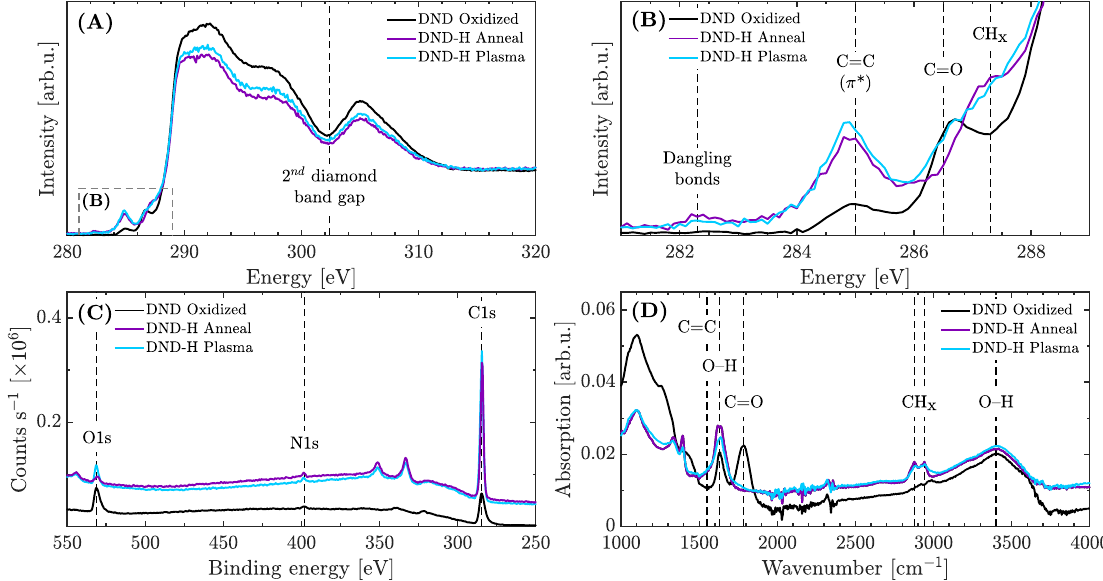
Figure 3. Spectroscopic characterization of hydrogenated DND materials and the oxidized starting material. ( A ) NEXAFS spectra of carbon K-edge; ( B ) carbon K-edge spectra displayed between 281 and 289 eV to highlight pre-edge features; ( C ) XPS survey; and ( D ) FTIR spectra. Features of interest are marked with dashed